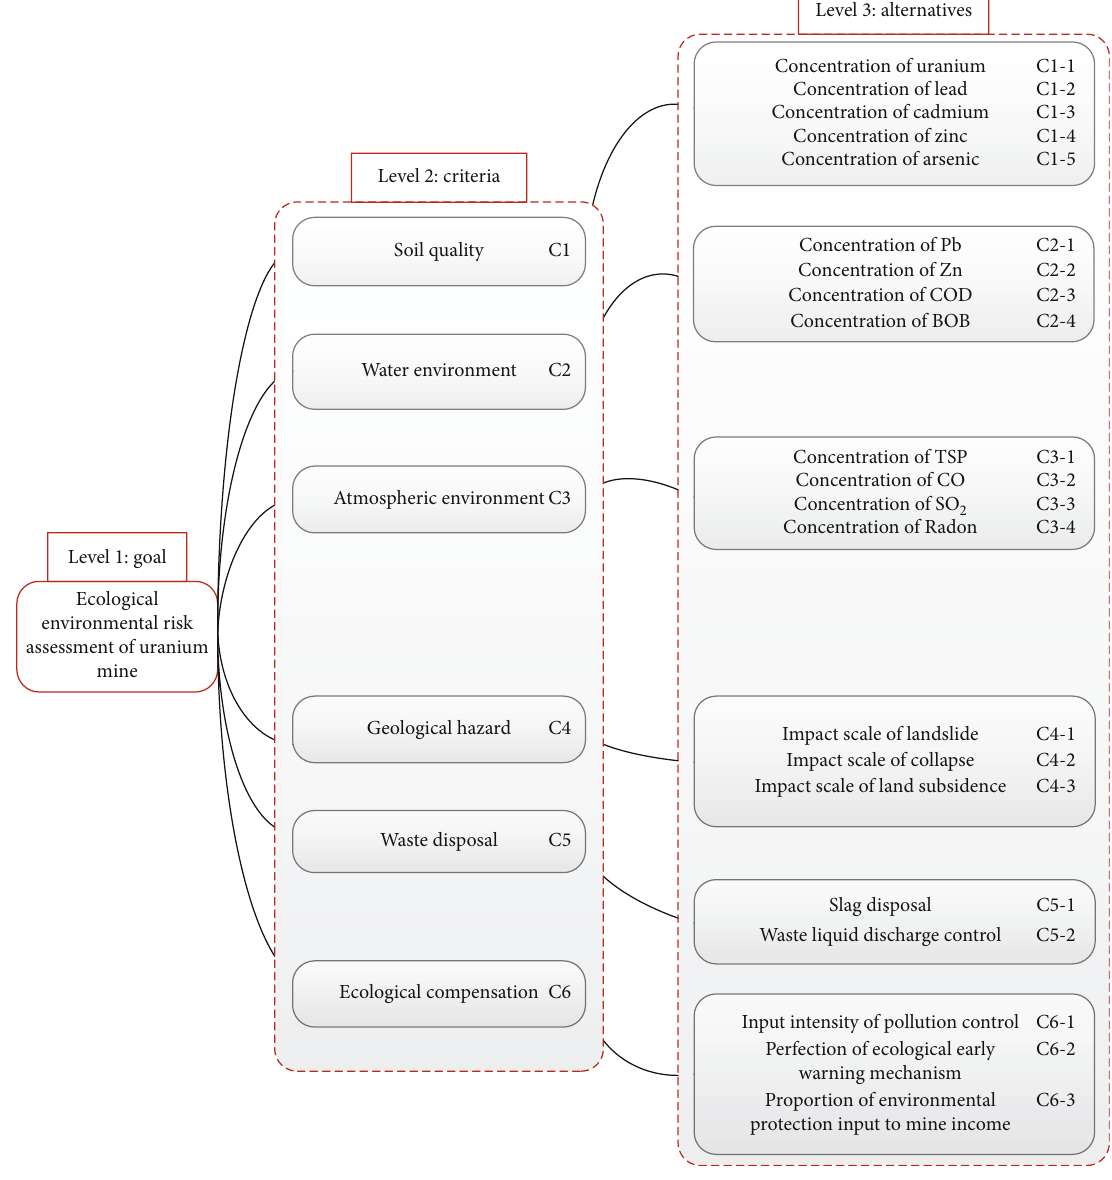
Figure 2: The diagram of environmental safety level analysis in coal mines. Table 2: Statistical compensation indexes for mine ecological